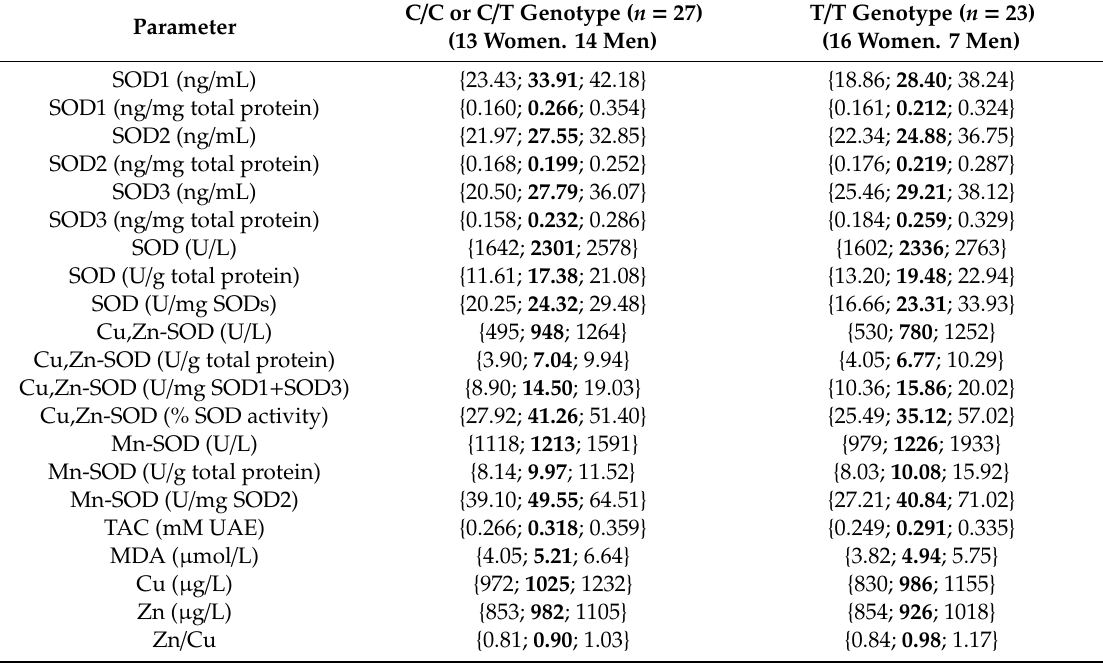
Table A1. Values of selected pro- and antioxidative parameters, and concentration of selected metals, in context of genotypic variability of rs5746105 ( SOD2 ), in non-obese individuals.